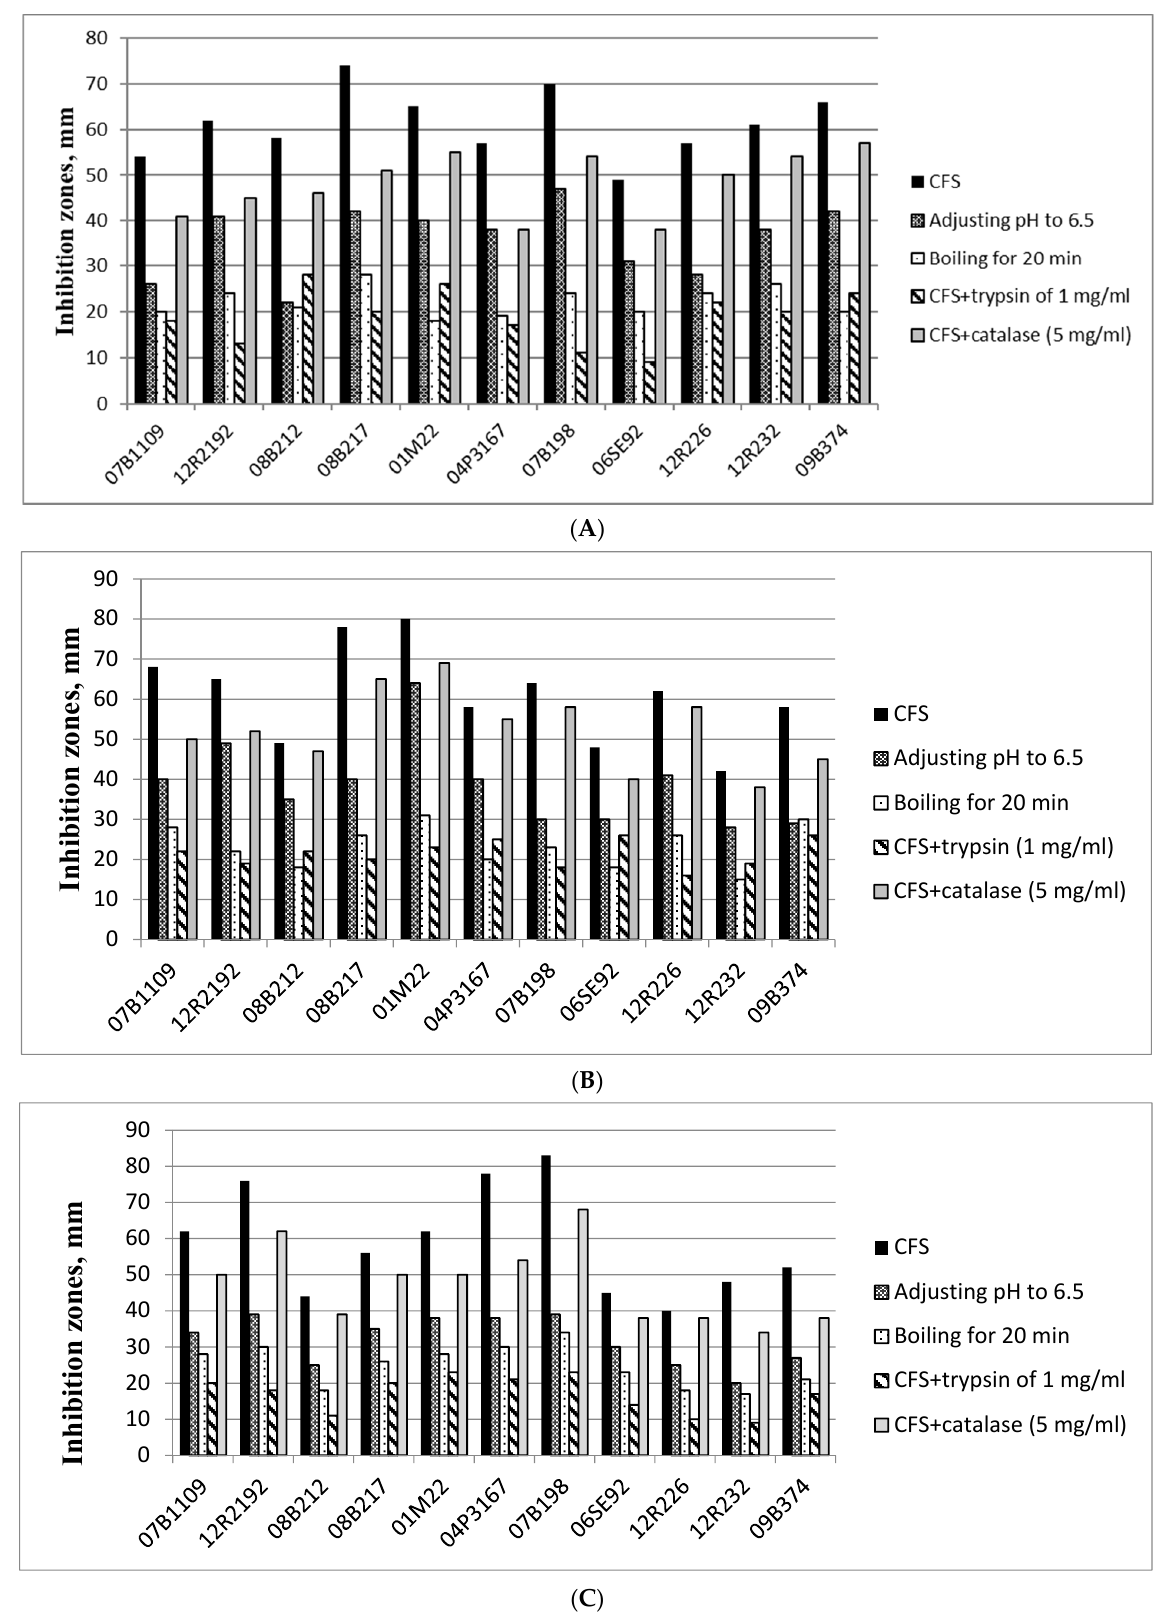
Figure 1. Antibacterial activity of selected LAB from Bulgarian sourdoughs against Bacillus subtilis NBIMCC 3562 ( A ), Staphylococcus aureus NBIMCC 3081 ( B ) and Salmonella enterica NBIMCC 8691 ( C